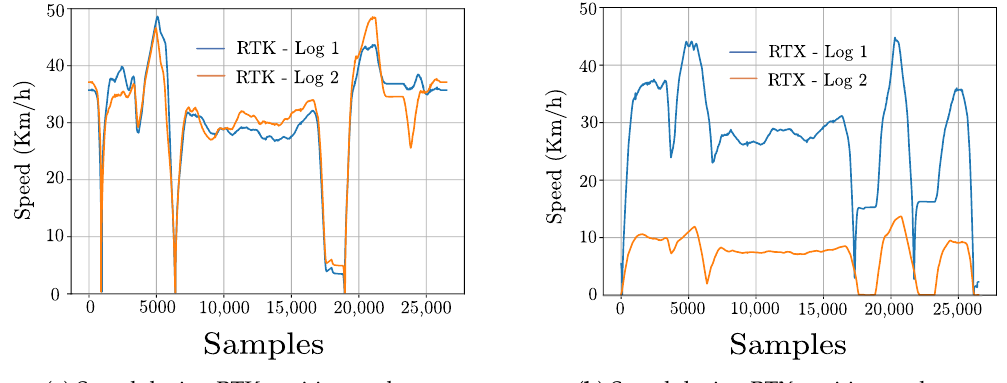
Figure 8. Speed of the vehicle for laps around the University of